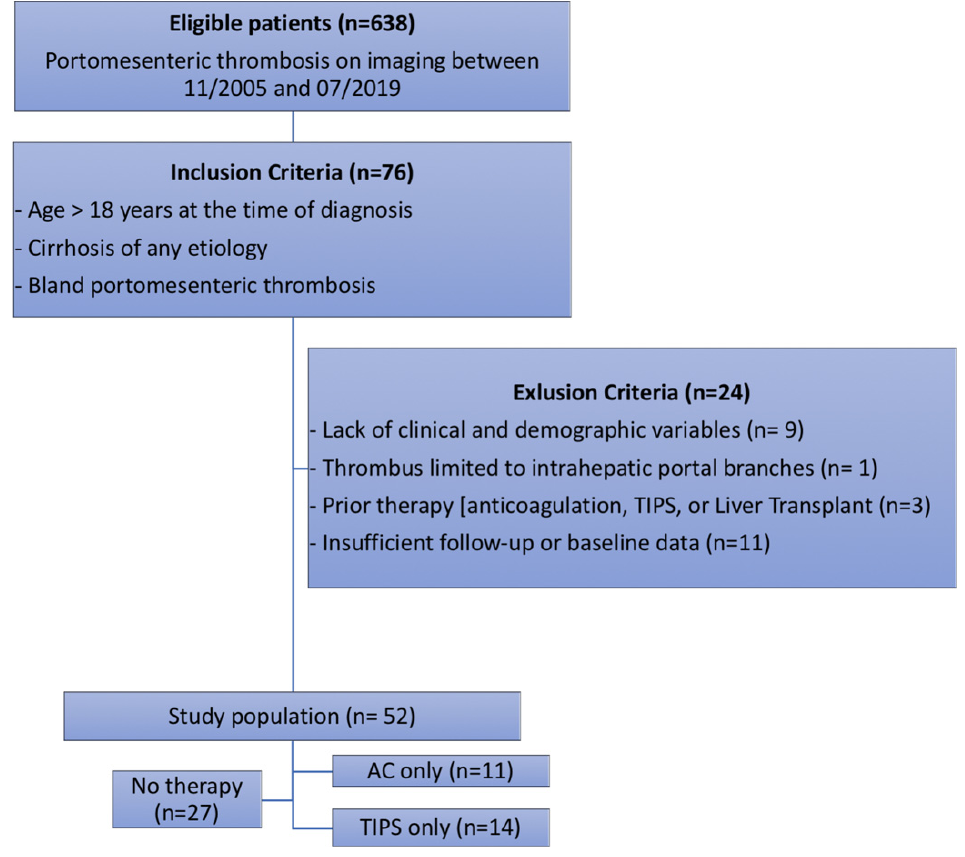
Figure 1. Study design flowchart.